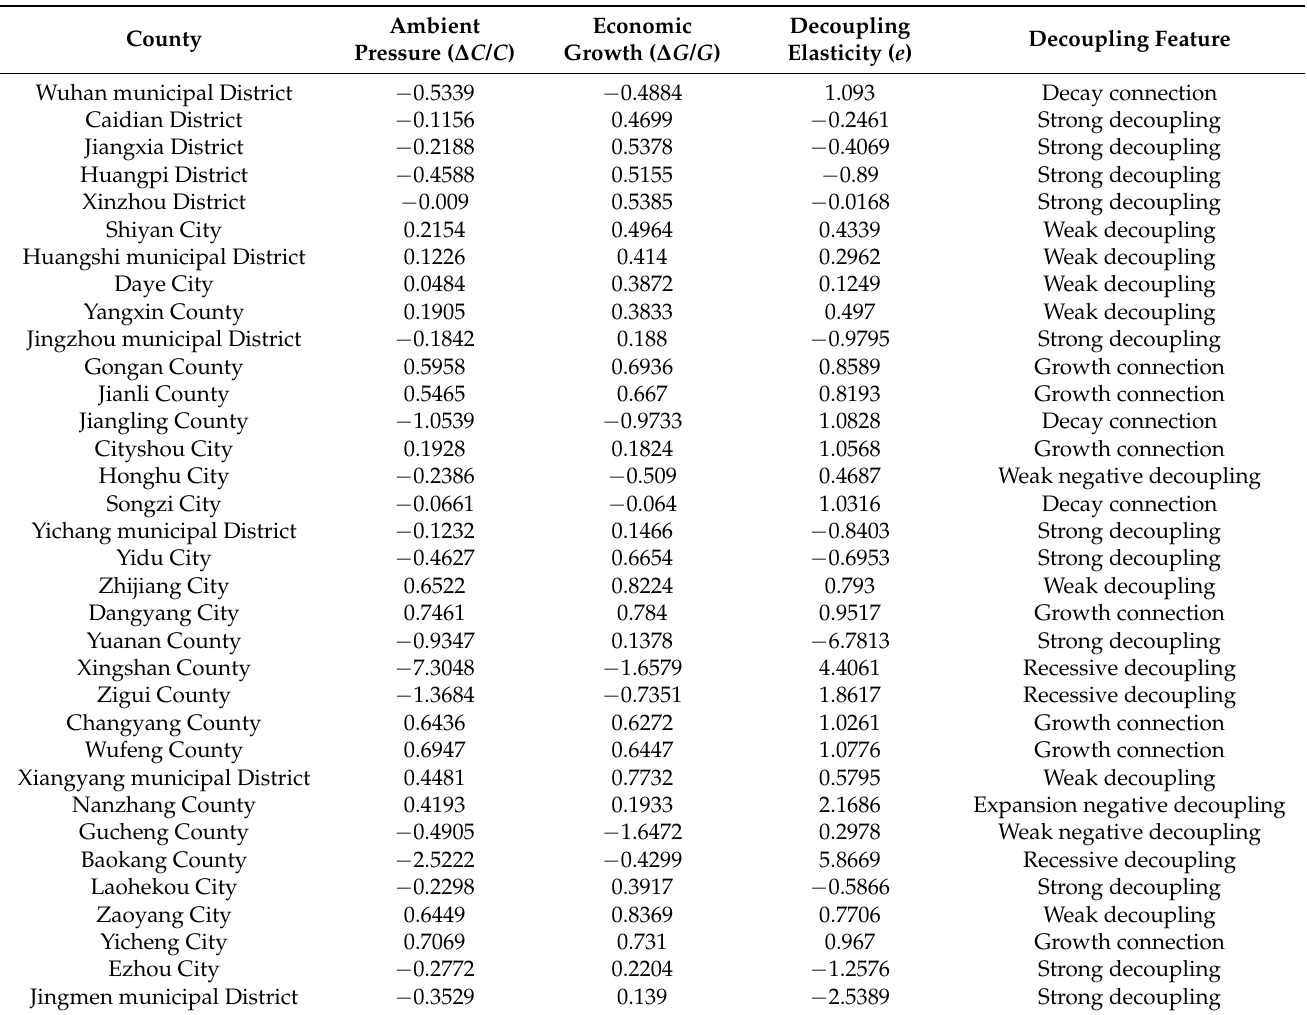
Table A3. Decoupling characteristics of carbon emissions and agricultural economic growth from 2010 to